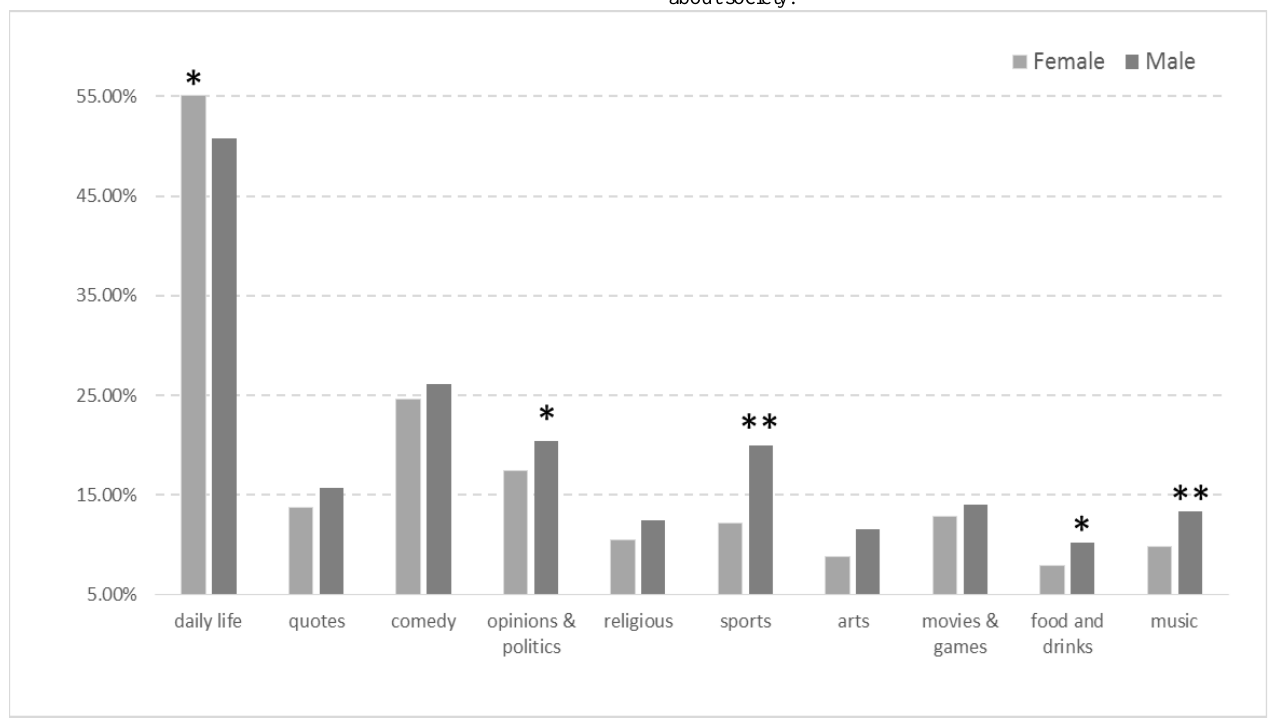
Figure 1: Frequencies of FSU topics as classified by human judges. Single asterisk indicates differences at p<0.05, double asterisk indicates differences at